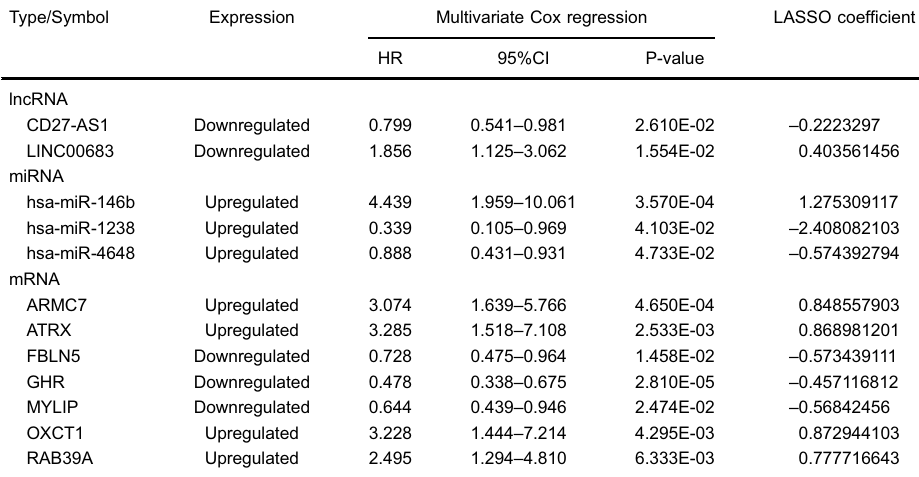
Table 2. The 12-gene-based signature.